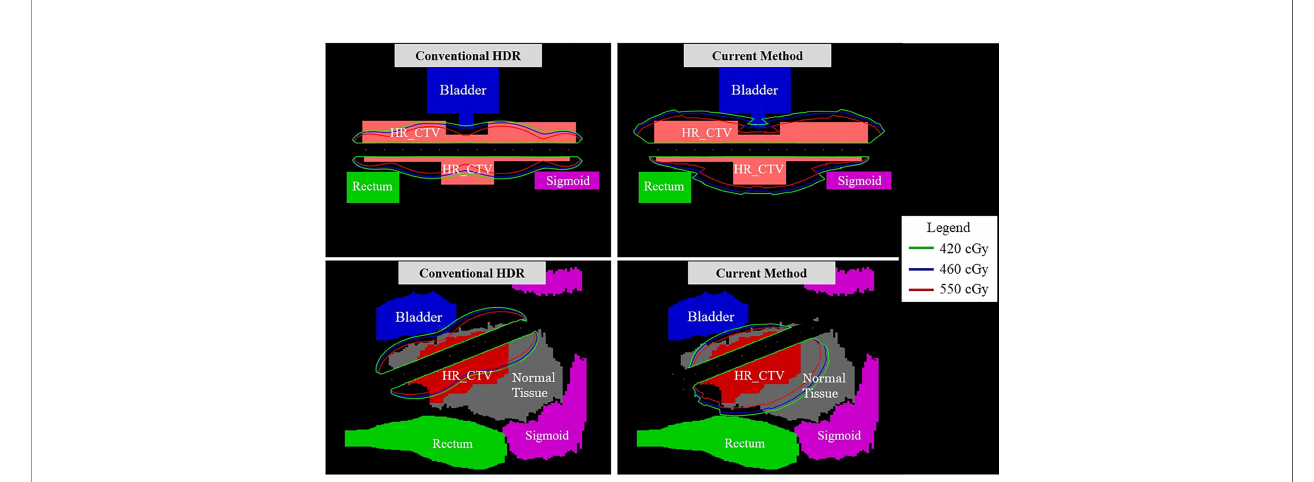
FIGURE 8 | A comparison of the dose distributions between the conventional method and proposed.